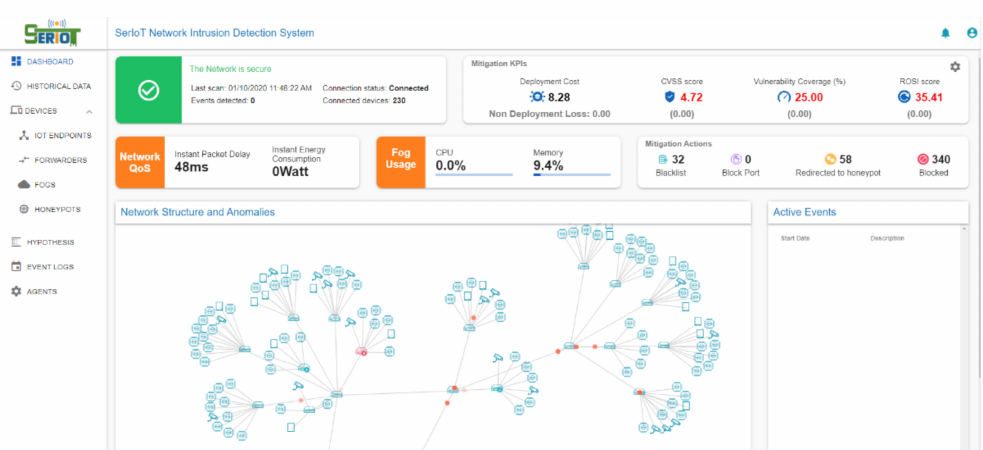
Figure 5. The user interface provided by the visual analytics module, functioning as the dashboard of the entire system. It monitors the proposed system and displays real-time information about the IoT network security